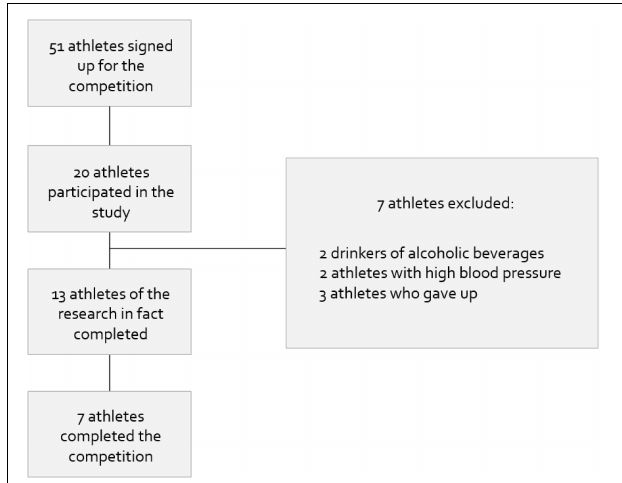
FIGURE 1 | Flow of participants during the